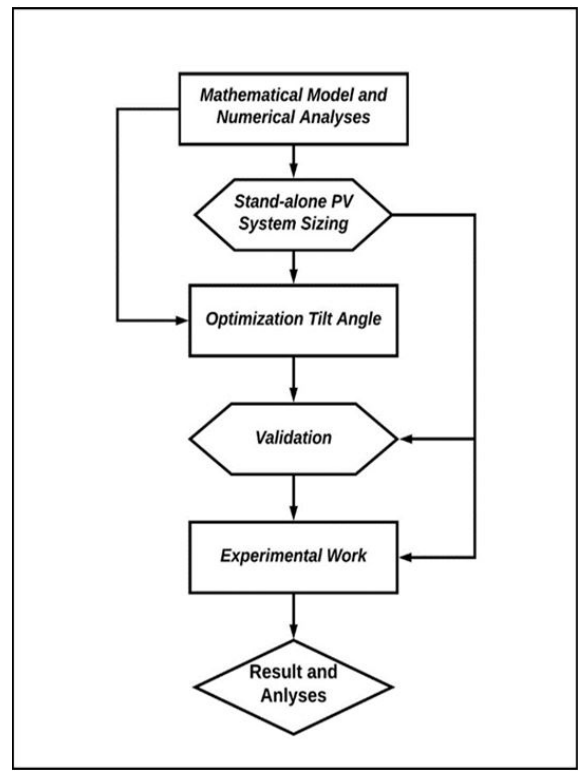
Figure 1. Flow chart of